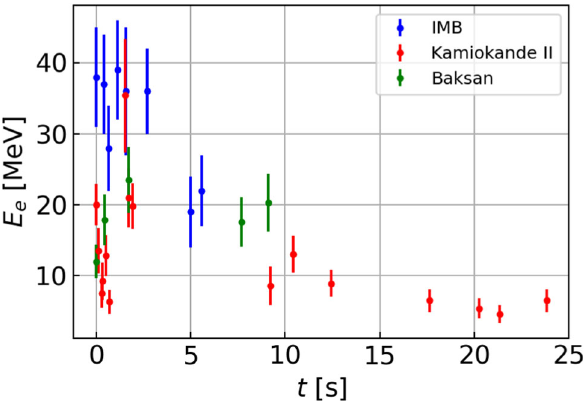
Fig. 2 Positron energy and relative time from the IMB, Kamiokande II and Baksan detectors, with a total of 29 events